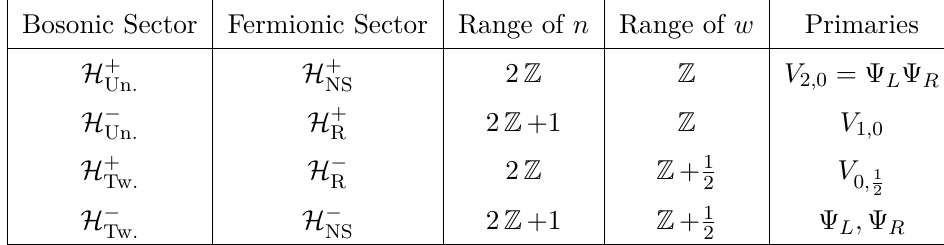
-associated theories, 2 and Dirac [ R ] theories, as n 2